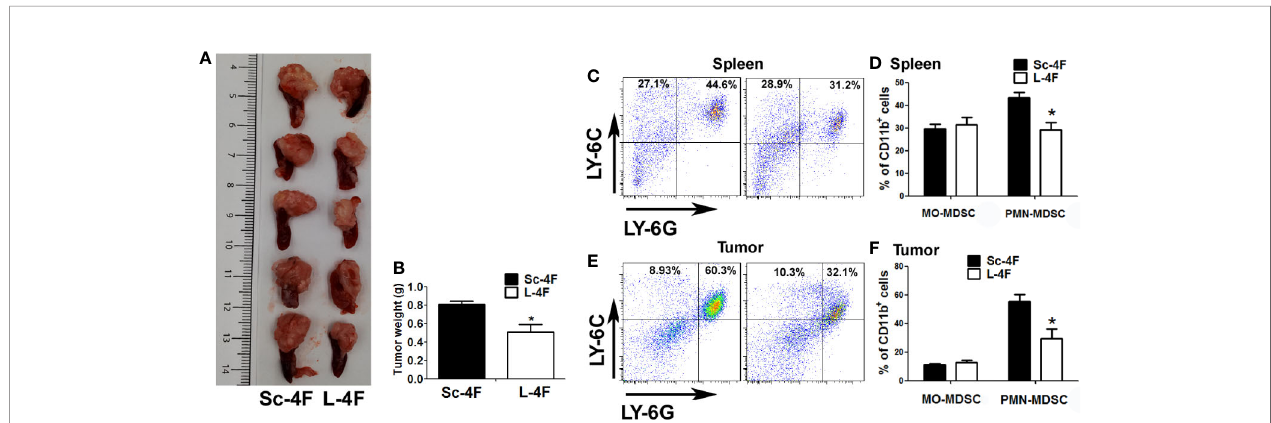
FIGURE 1 | L-4F inhibits the in fi ltration of PMN-MDSCs in mice with pancreatic cancer. H7 cells were implanted into the pancreas. Mice were euthanized after 2 weeks of L-4F or Sc-4F treatment. (A) Representative tumors from Sc-4F- or L-4F-treated mice. (B) Final tumor weights (*P < 0.05). (C, E) One representative result from each experiment. (D) The percentages of MO-MDSCs and PMN-MDSCs among the splenocytes and (F) tumor-in fi ltrating cells in the tumor tissue (*P <